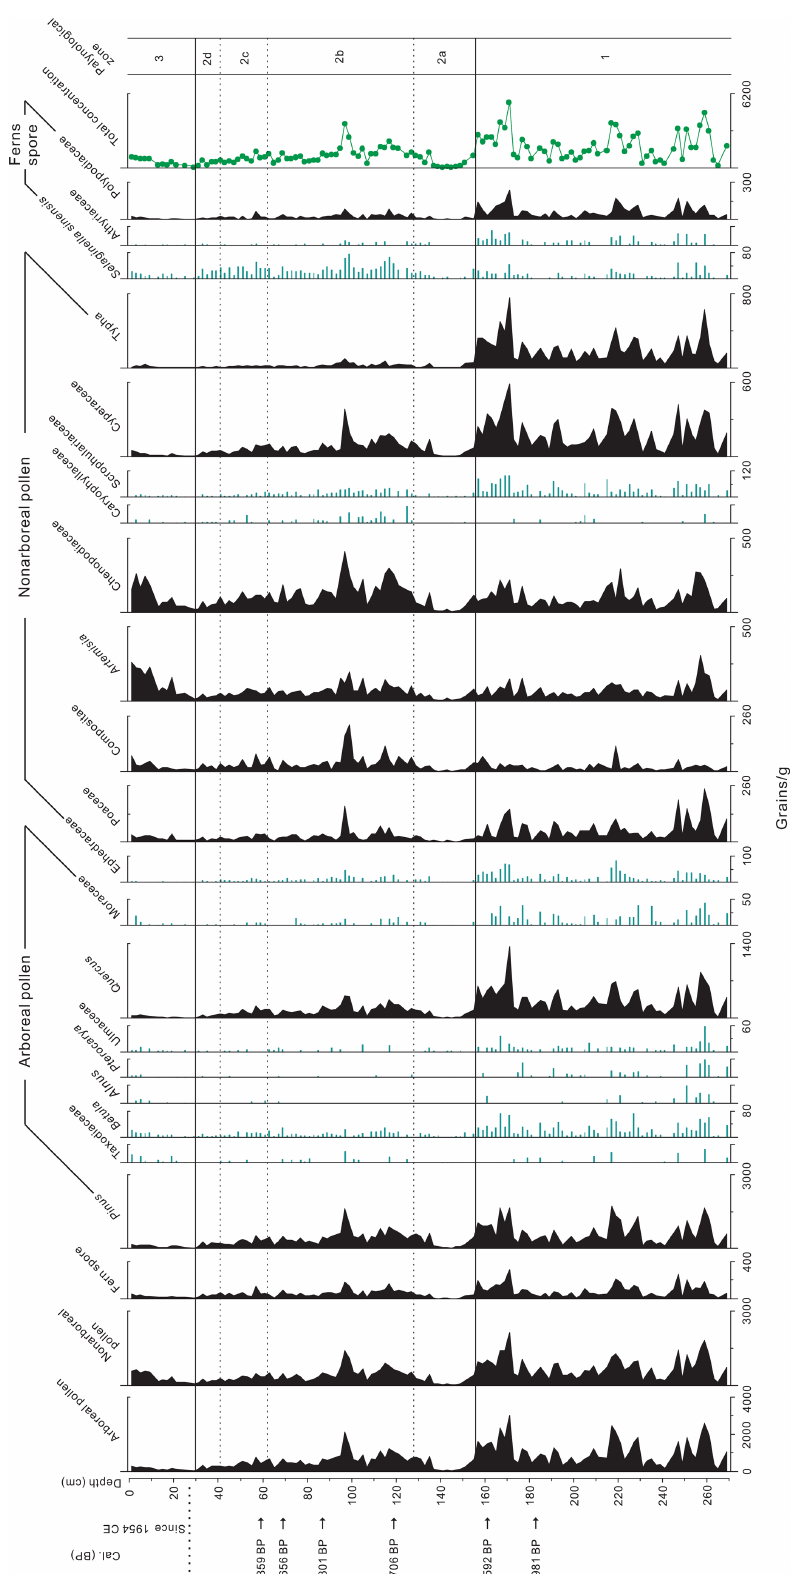
Figure 5. Concentration diagram of the principal pollen taxa from core